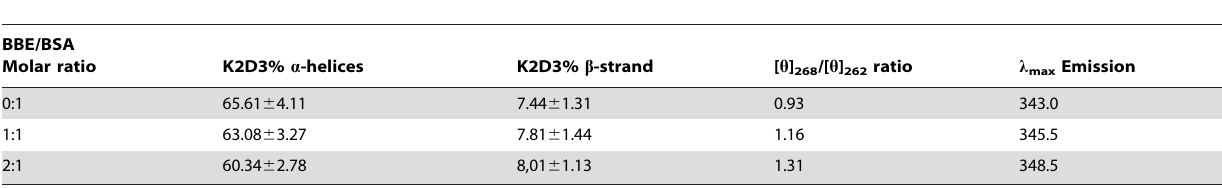
Table 2. 1,2 - Bis(2-Benzimidazolyl) 1,2-Ethanediol induced conformational alteration in BSA.